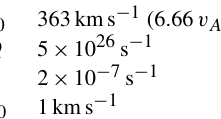
Table 3. Physical parameters of the model comet.